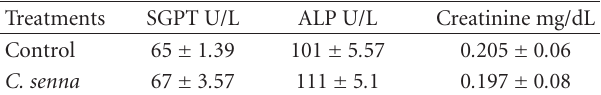
Table 6: E ff ect of the most e ff ective plant extract ( C. senna ) on serum GPT, ALT, and creatinine of treated rats at dose level of 500mg/kg body weight.